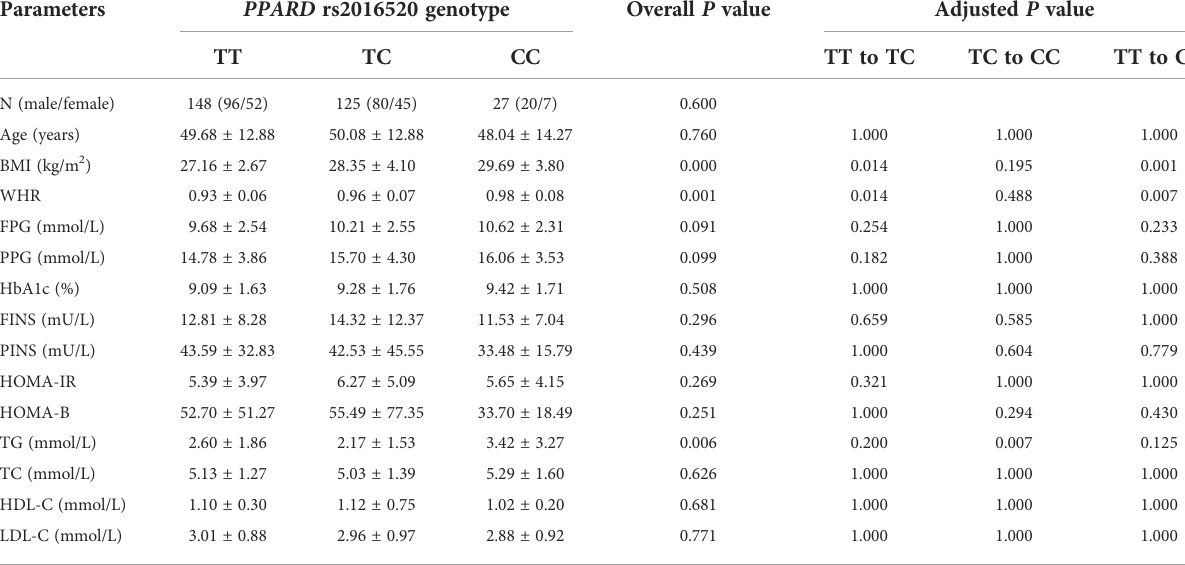
TABLE 2 The baseline characteristics in type 2 diabetes mellitus (T2DM) patients with various PPARD rs2016520 genotypes before treatment with exenatide (n=300). Parameters